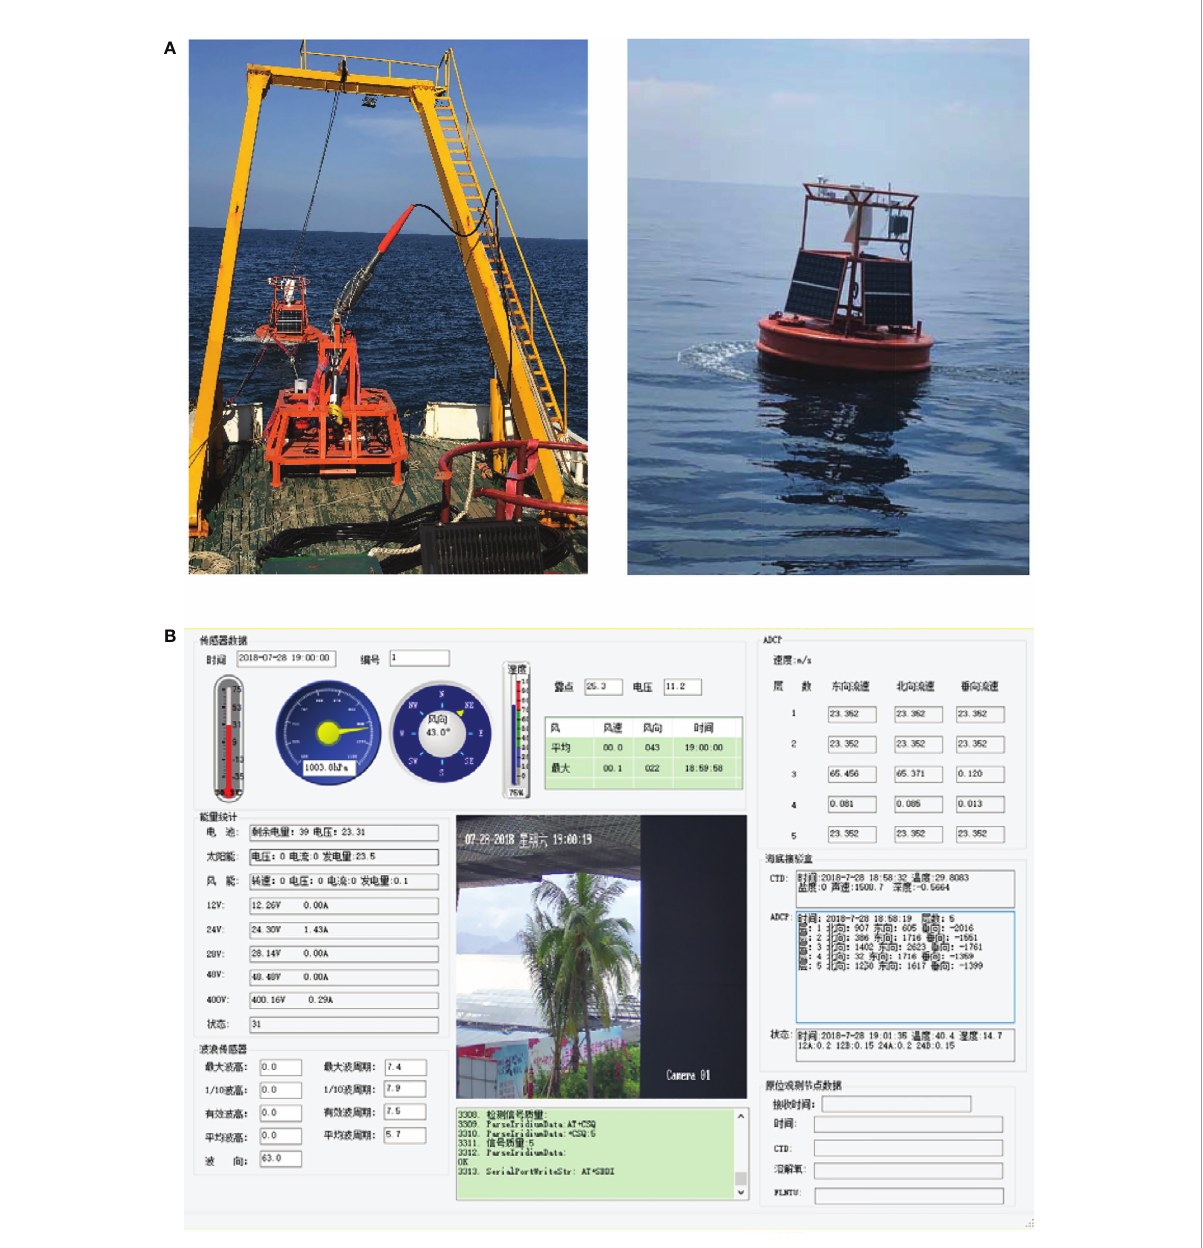
FIGURE 10 Recovery of the system and the shore control interface. (A) Towing and launch of the buoy. (B) The shore control